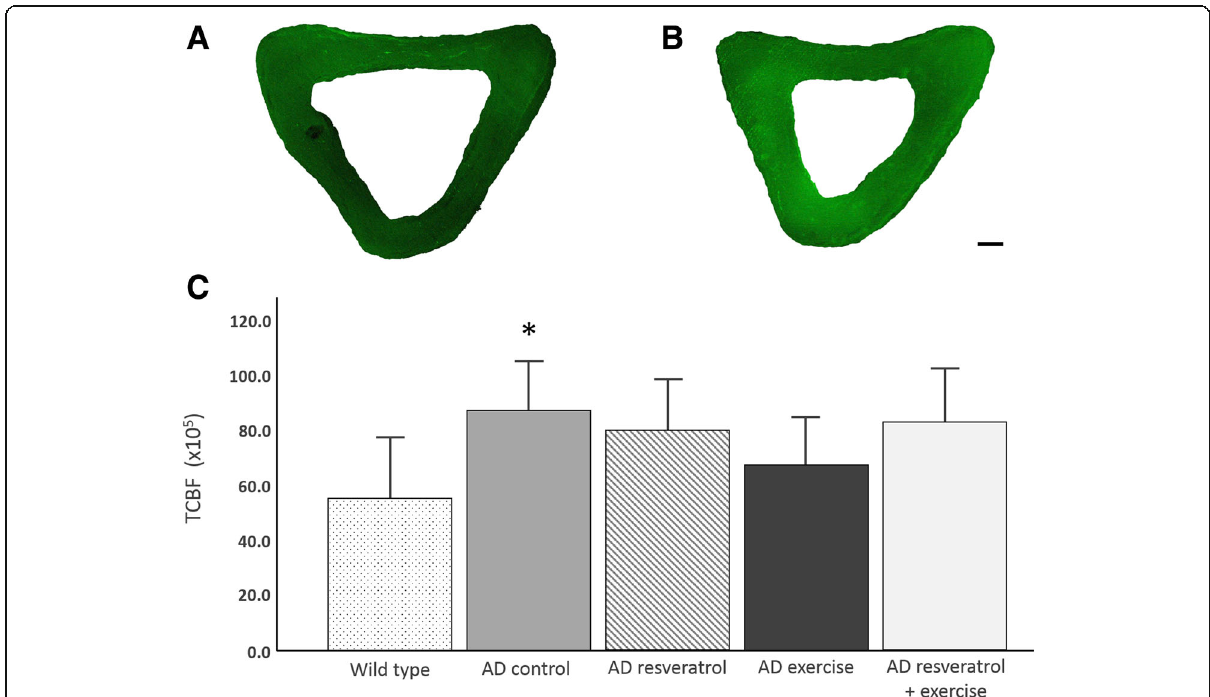
Fig. 2 Comparison of corrected total bone fluorescence (CTBF) among treatment groups. a Tibia of a wild type mouse. b Tibia of an AD control mouse. c AD controls differed significantly from wild type mice (* P < 0.05). None of the AD treatment groups differed significantly from AD controls, nor did they differ significantly from wild type mice ( P > 0.05 in both cases). Data are expressed as mean ± 2 SE. Scale bar 100 μ